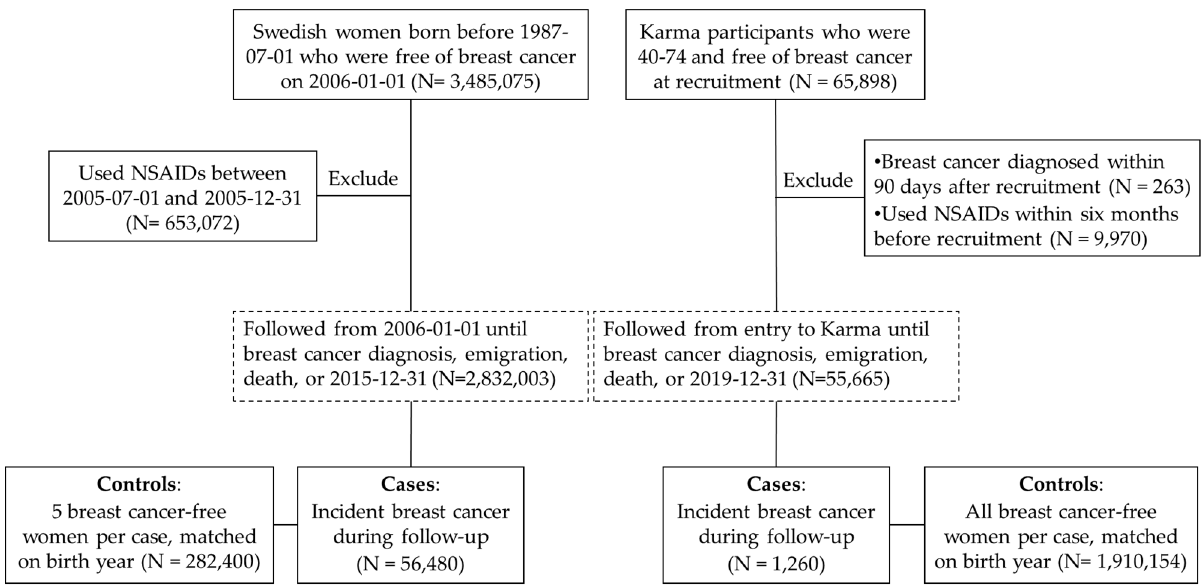
Figure 1. Flowchart of the study. Numbers in controls do not reflect unique individuals because individuals could be included in more than one risk set.